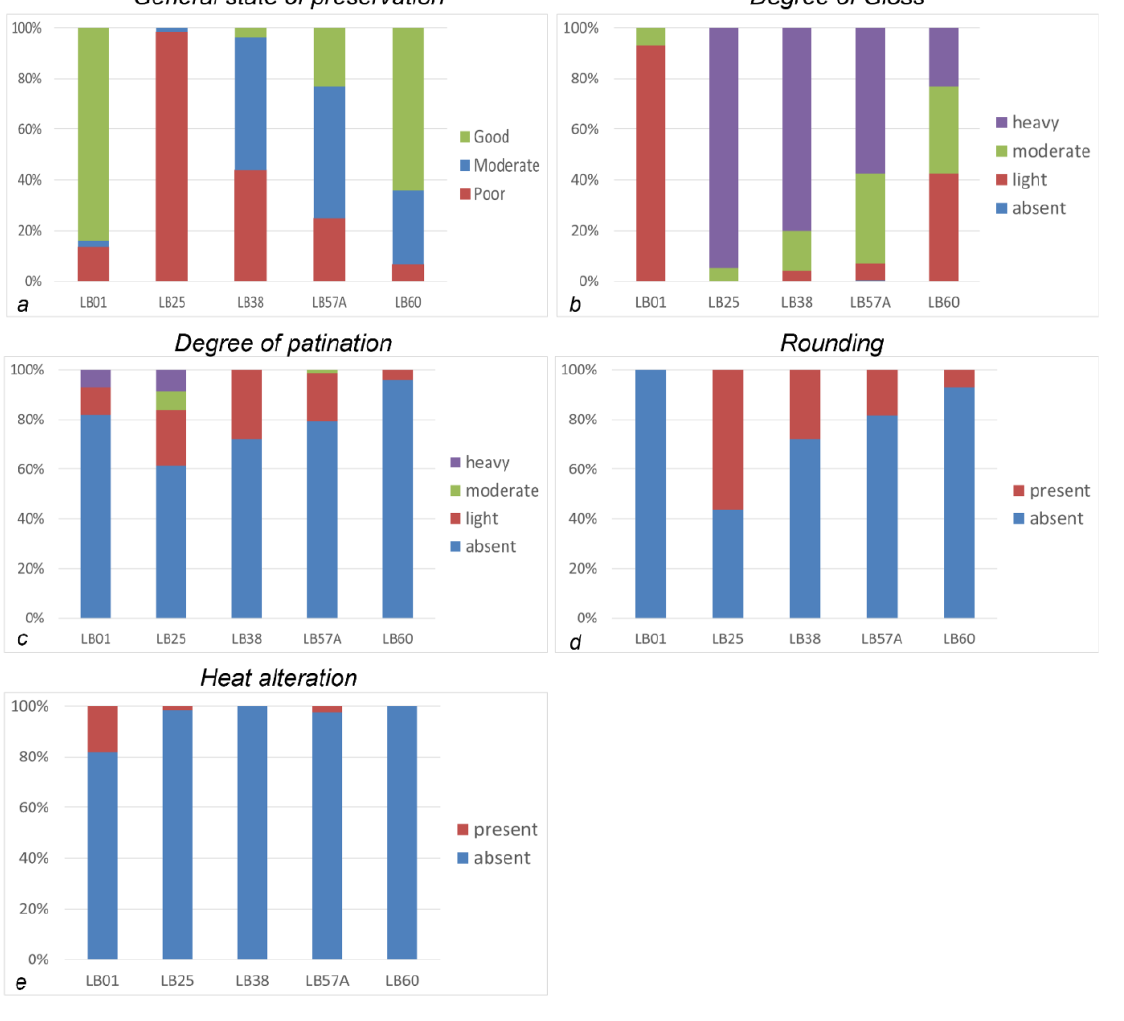
Figure 3. Summary of the recorded surface alterations including a) the general state of preservation; b) the degree of gloss; c) the degree of patination; d) the presence of edge rounding; e) the presence